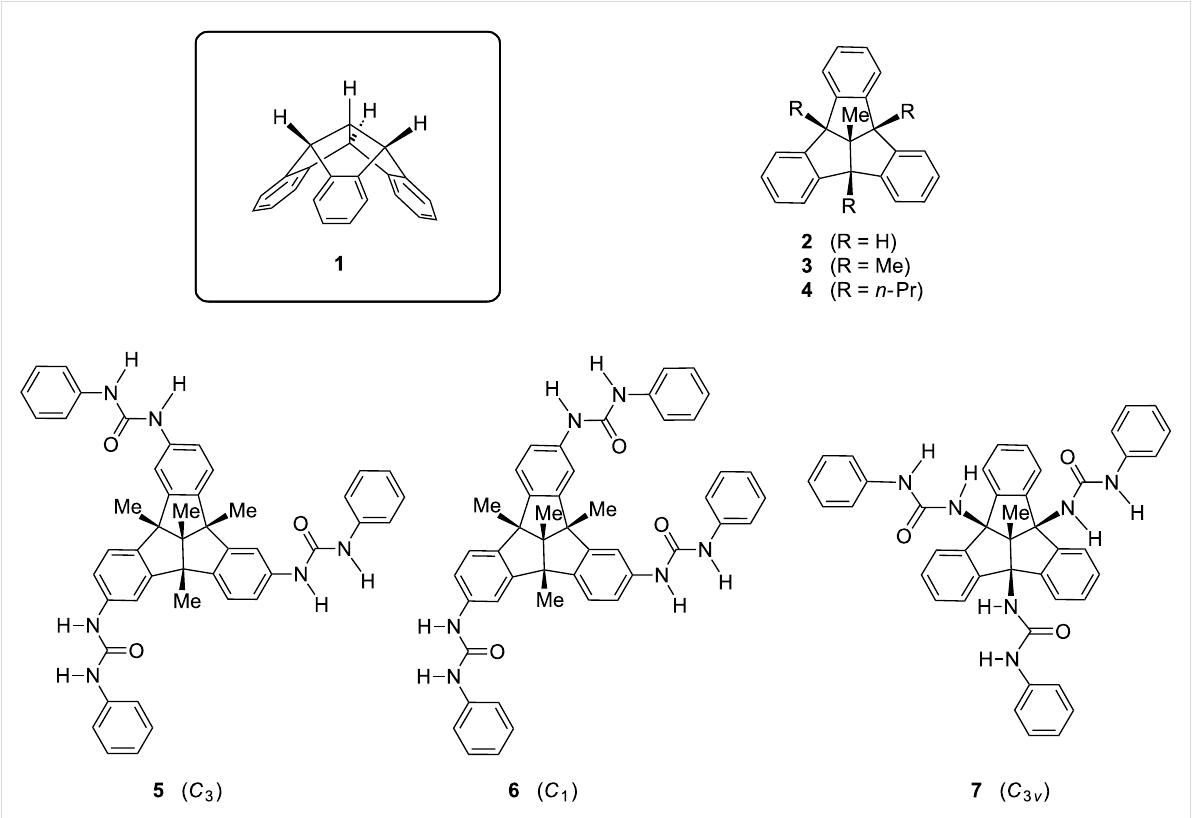
Figure 1: Parent TBTQ 1 , three bridgehead-alkylated congeners 2 – 4 , and three TBTQ tris-urea derivatives 5 – 7 bearing the functional groups in three different spatial